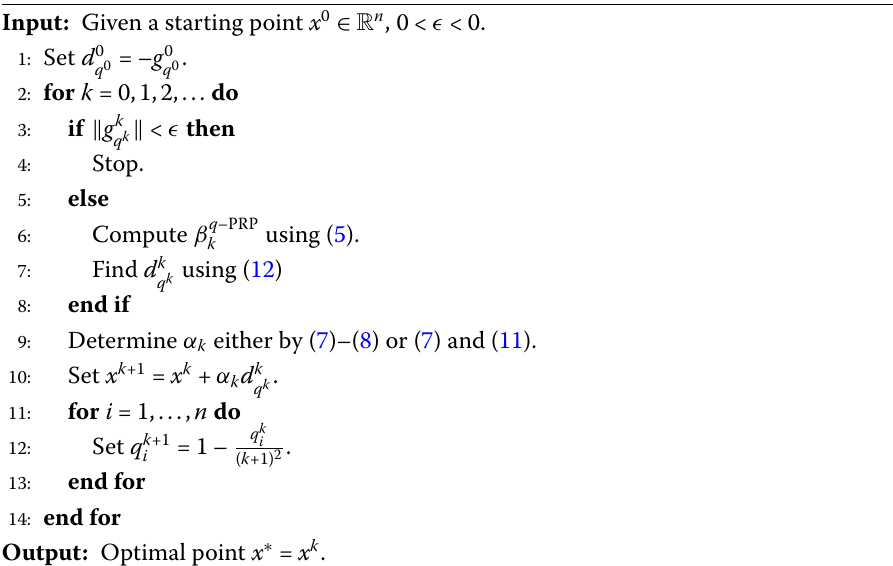
Algorithm 1 q -PRP conjugate gradient